Question: Write a caption explaining this figure to a reader.
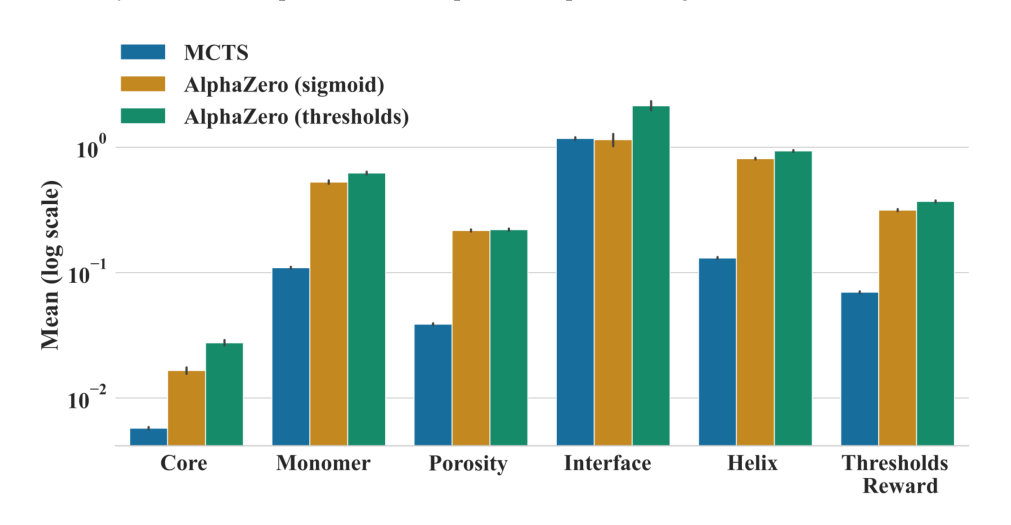
Answer: Protein score distributions means with 95% bootstrap confidence intervals. AlphaZero, and more specifically AlphaZero (thresholds) systematically outperforms MCTS on all scores.